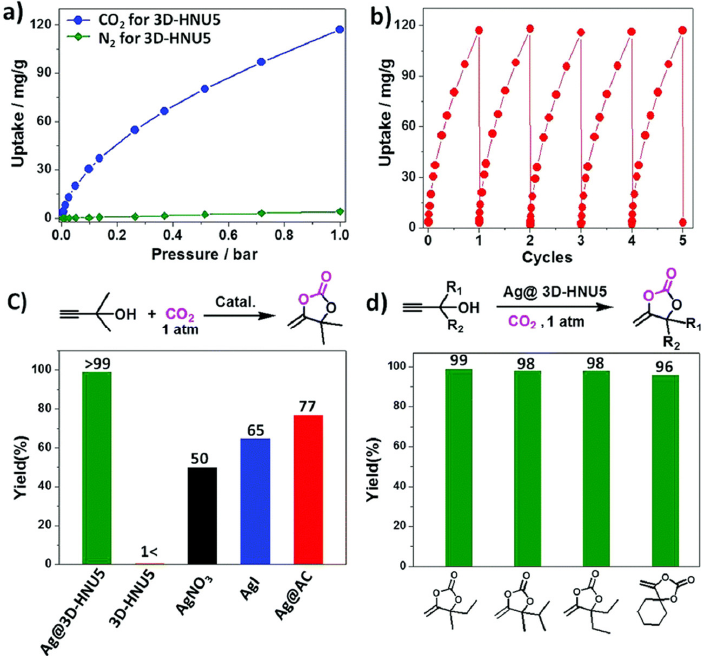
Figure 23. ( a – d ) The conversion and capture of CO 2 using azine-linked 3D COF [58].